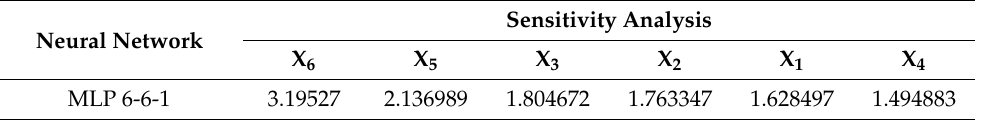
Table 5. Neural network (MLP 6-6-1) sensitivity